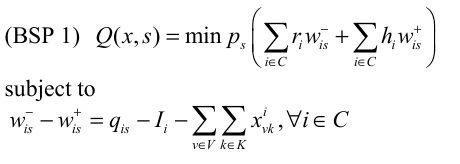
Algorithm 1. Single-cut based Benders decomposition algorithm